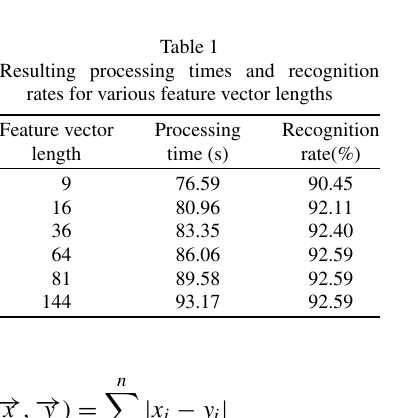
Fig. 2. Graphical representation of feature vector selection.